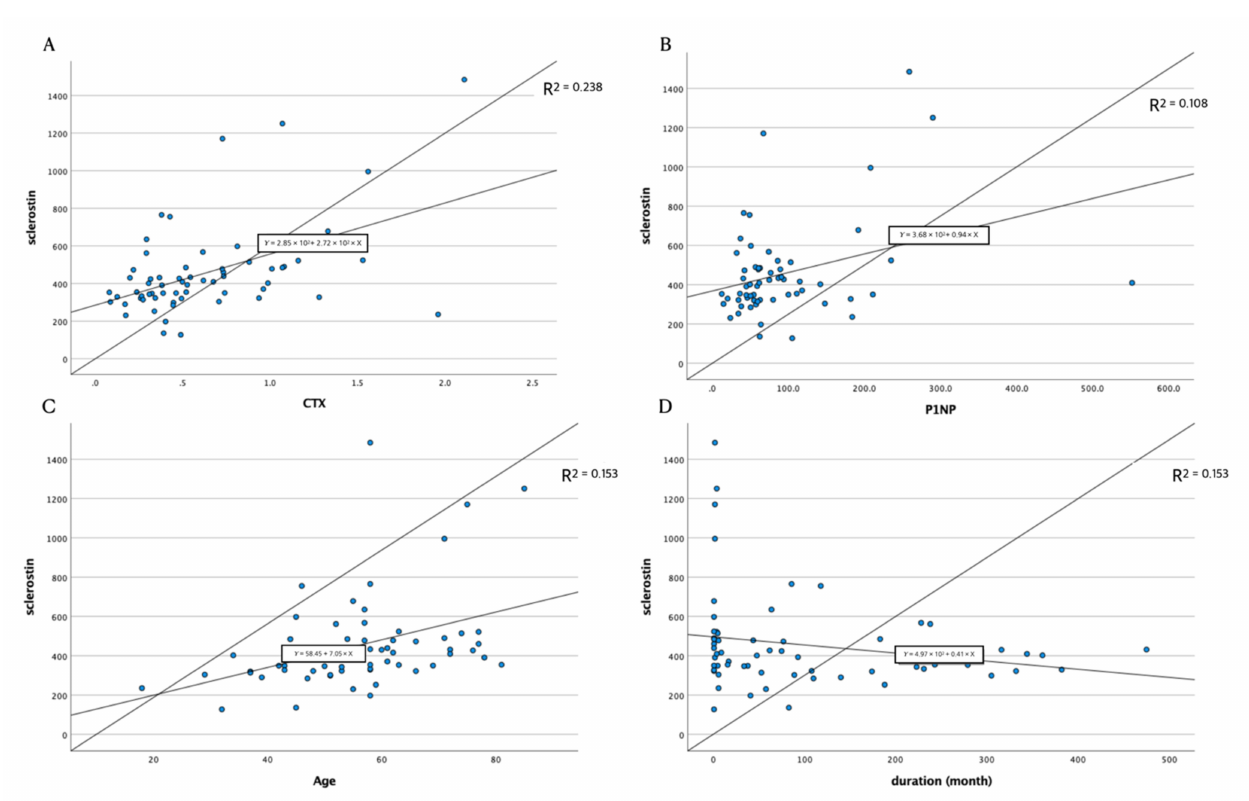
Figure 1. Scatterplot of sclerostin levels with bone biomarker levels, age, and duration. Bone biomarkers ( A , B ) and age ( C ) showed a positive relationship with sclerostin. However, the duration did not establish a significant relationship with sclerostin ( D ). In addition, there was a wide range variation of sclerostin serum concentration in the acute